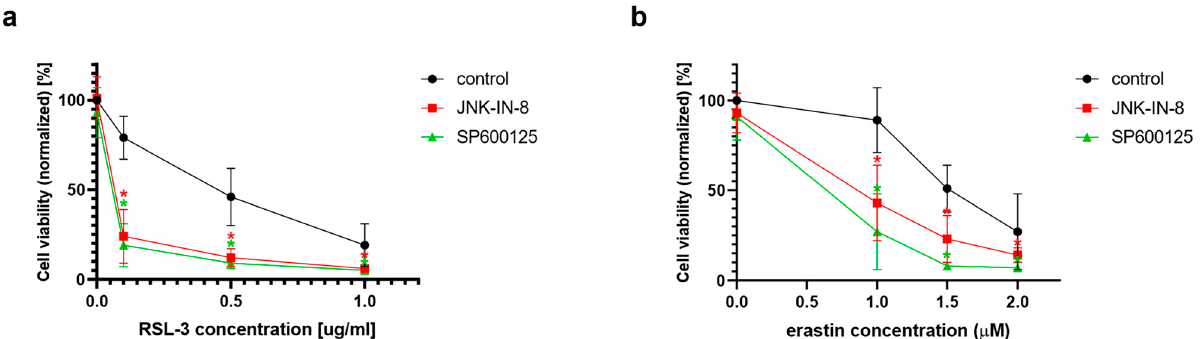
Figure 1. Pharmacological inhibition of JNK activity enhances the effect of ferroptosis inductors in HT-1080 cells. HT-1080 cells were treated on a 96-well plate for 24 h with the ferroptosis-inducing compounds ( a ) RSL-3 (0.1–1 µ g/mL) or ( b ) erastin (1–2 µ M). RSL-3 treatment, in all three applied concentrations, and 1.5 µ M and 2 µ M erastin treatment, significantly decreased cell viability. Co- treatment with JNK inhibitors, JNK-IN-8 (10 µ M, the first irreversible JNK inhibitor) or SP600125 (5 µ M, a frequently used reversible, ATP-competitive JNK inhibitor) significantly decreased cell viability compared to only RSL-3 or erastin treatment. Cell viability was measured by MTT assay. Data are normalized to an untreated control, and each data point represents the average ± SD from at least three independent experiments. * Significantly different ( p < 0.05) from group control (RSL-3 or erastin treated without co-treatment).